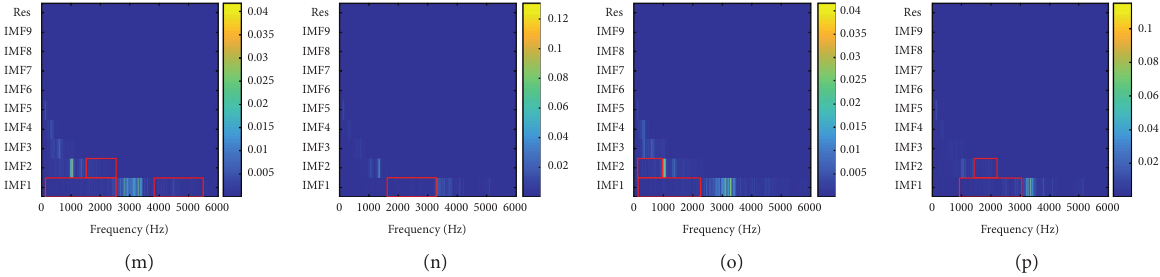
Figure 4: Frequency distribution of each IMF of the original signal. (a) N (drive end). (b) N (fan end). (c) I-D (drive end). (d) B-F (fan end). (e) B-D (drive end). (f) B-D (fan end). (g) O6-D (drive end). (h) O6-D (fan end). (i) I-F (drive end). (j) I-F (fan end). (k) B-F (drive end). (l) B-F (fan end). (m) O3-F (drive end). (n) O3-F (fan end). (o) O12-F (drive end). (p) O12-F (fan end). Res means residual component.